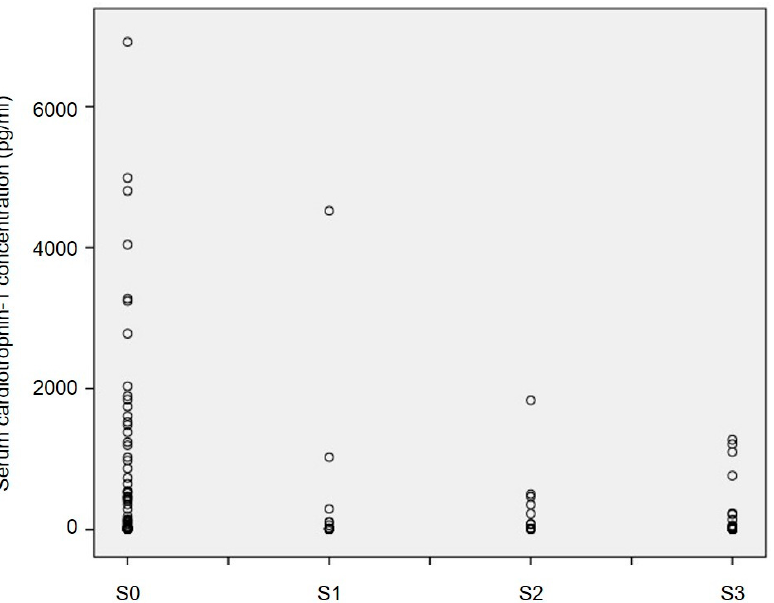
Figure 1. Serum concentrations of cardiotrophin-1 (CT-1) in subjects with NAFLD. Box and whisker plot of serum CT-1 concentrations in subjects with CAP < 238 dB/m (S0; n = 90), 238 ≤ CAP ≤ 259 dB/m (S1; n = 27), 260 ≤ CAP ≤ 290 dB/m (S2; n = 23), and CAP > 290 dB/m (S3; n = 42). The line inside the box represents the median of the distribution, the box top and bottom values are defined by the 25th and 75th percentiles, and the whiskers are minimum and maximum values. Table 1. Clinical characteristics of the enrolled study subjects. Table 2. Results of multivariate linear regression analysis between CT-1 and clinical